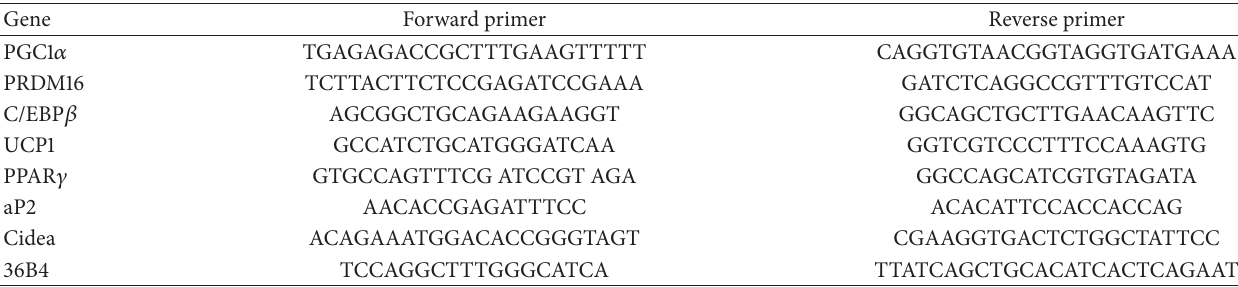
Table 1: The sequences of primers for the real-time